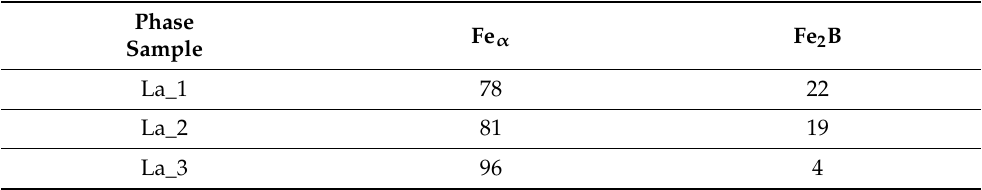
Table 5. Quantitative phase analyses of the main phases present in tested Fe-B-La-Al alloy tapes